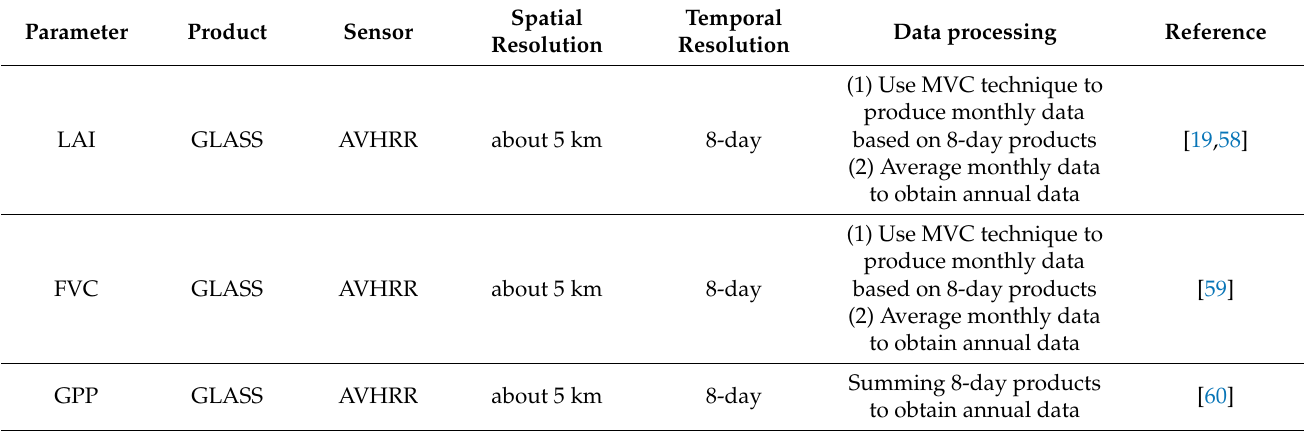
Table 1. Land surface parameter products used in this study as representative of vegetation dynamics.